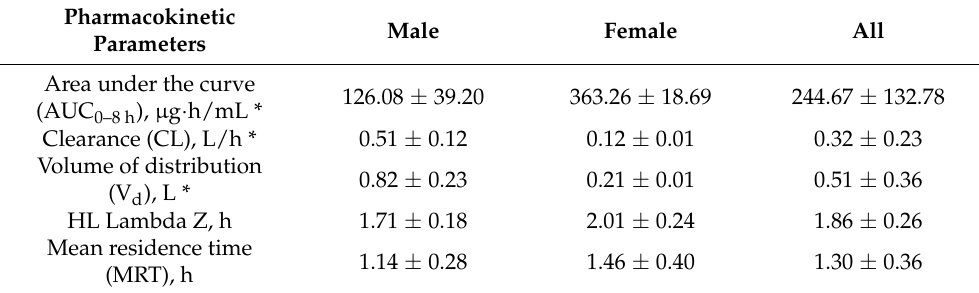
Table 1. Pharmacokinetic parameters estimated from the DBS drug levels following intravenous bolus administration of VPA in rats at dose of 200 mg/kg. Mean ± SD ( n = 10).